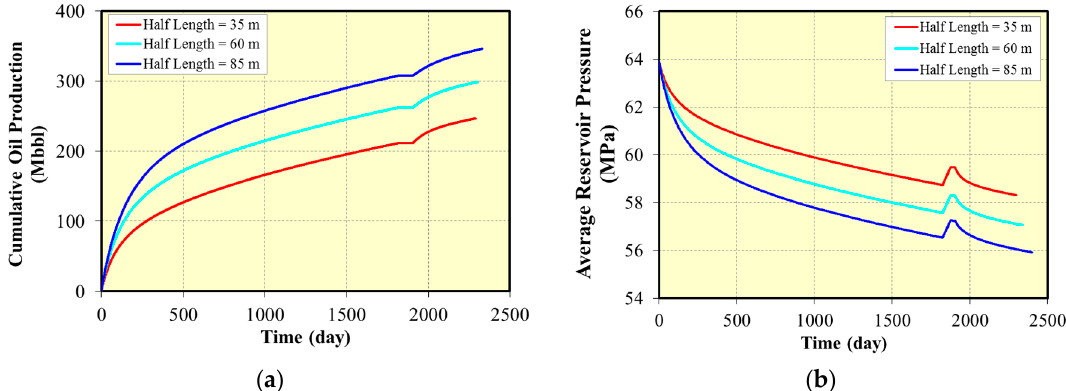
Figure 17. Effect of different half-length of hydraulic fractures with one huff-n-puff cycle on oil production and reservoir pressure: ( a ) Cumulative oil production for different half-length of hydraulic fractures; ( b ) Average reservoir pressure for different half-length of hydraulic fractures.